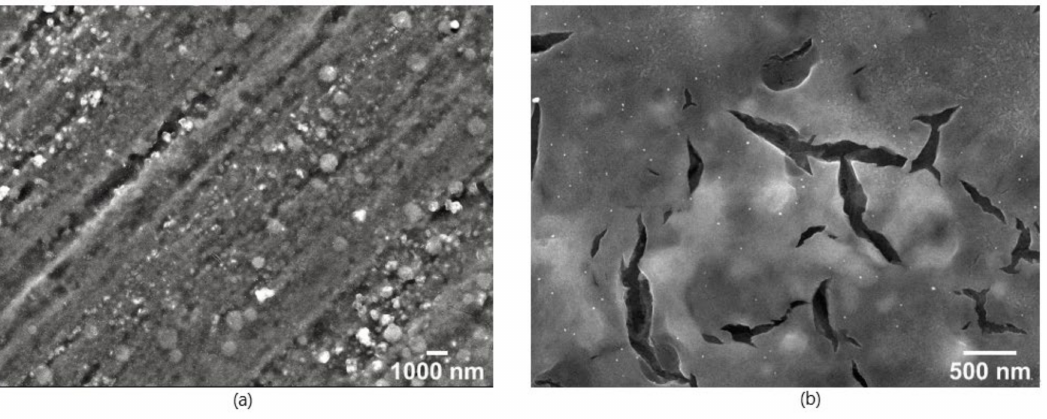
Figure 4. SEM images from a SERS substrate covered with a 4% TTIP solution, dried for 24 h under ambient air. Afterwards it was coated with 2 µ L of the AuNPs suspension. ( a ) 5000 × magnification, ( b ) 25,000 × magnification with a WD 4 mm and 10 kV acceleration